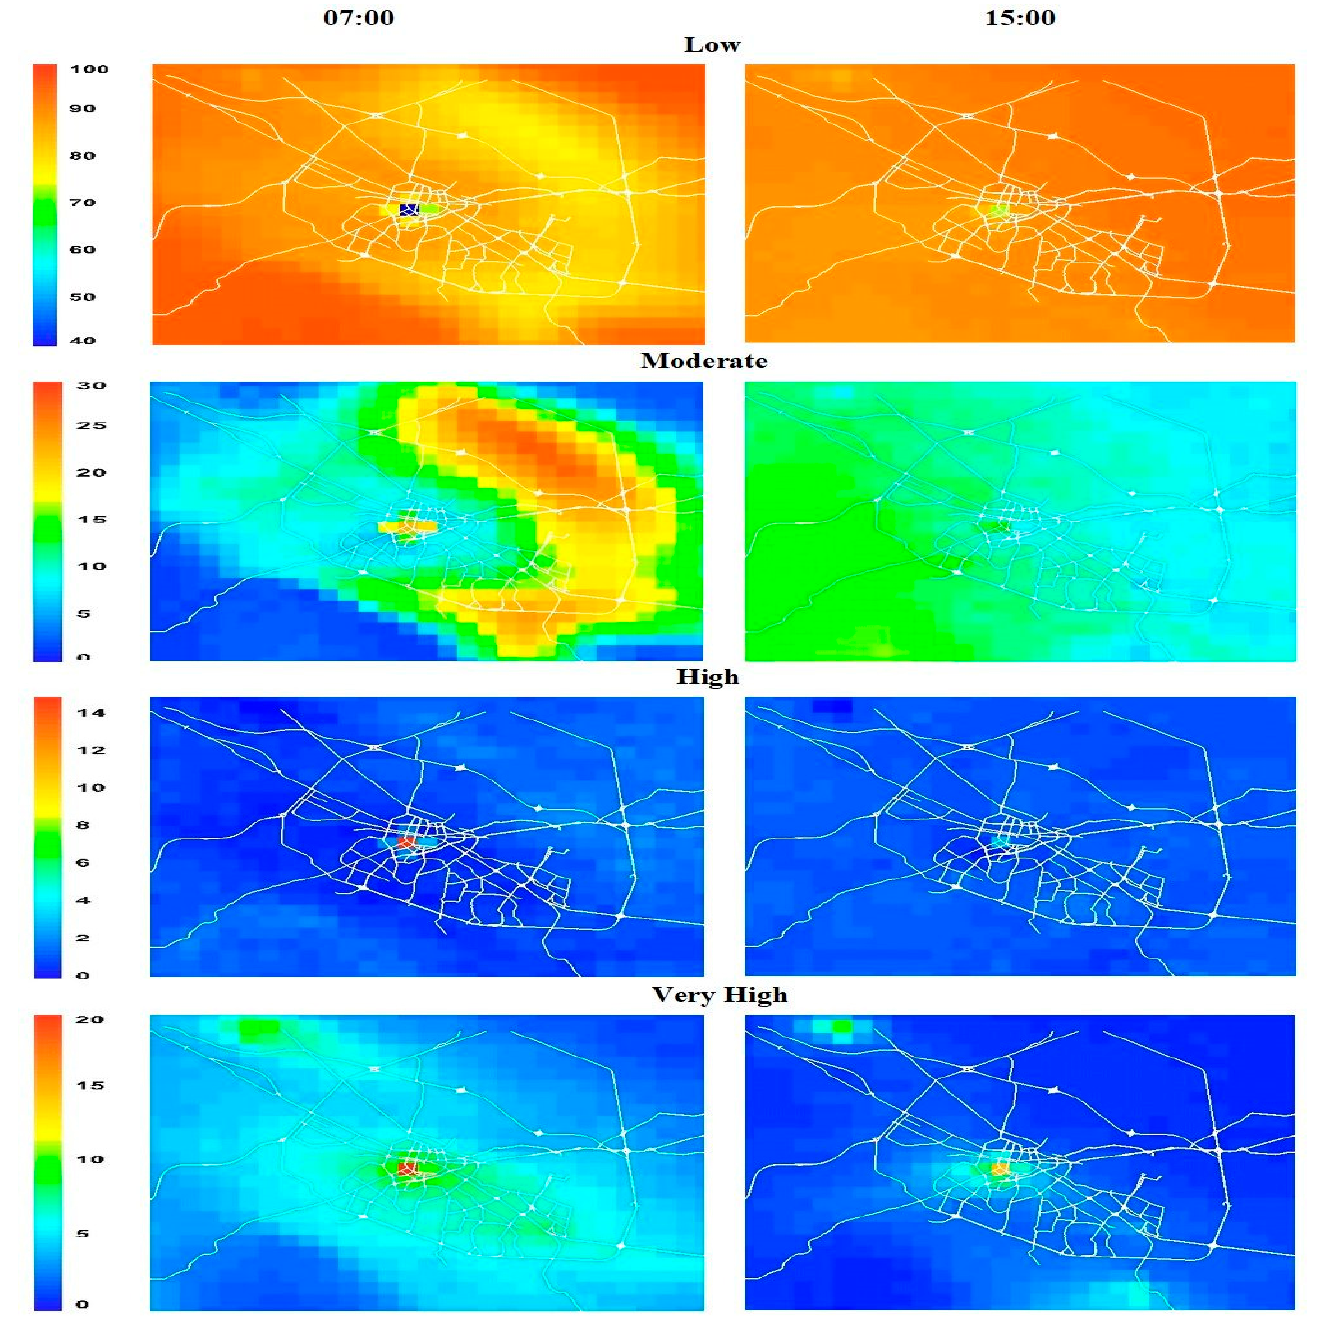
Figure 2. Annual recurrences (in %) of the AQI for the band Low, Moderate, High, and Very High for the territory of Sofia city.